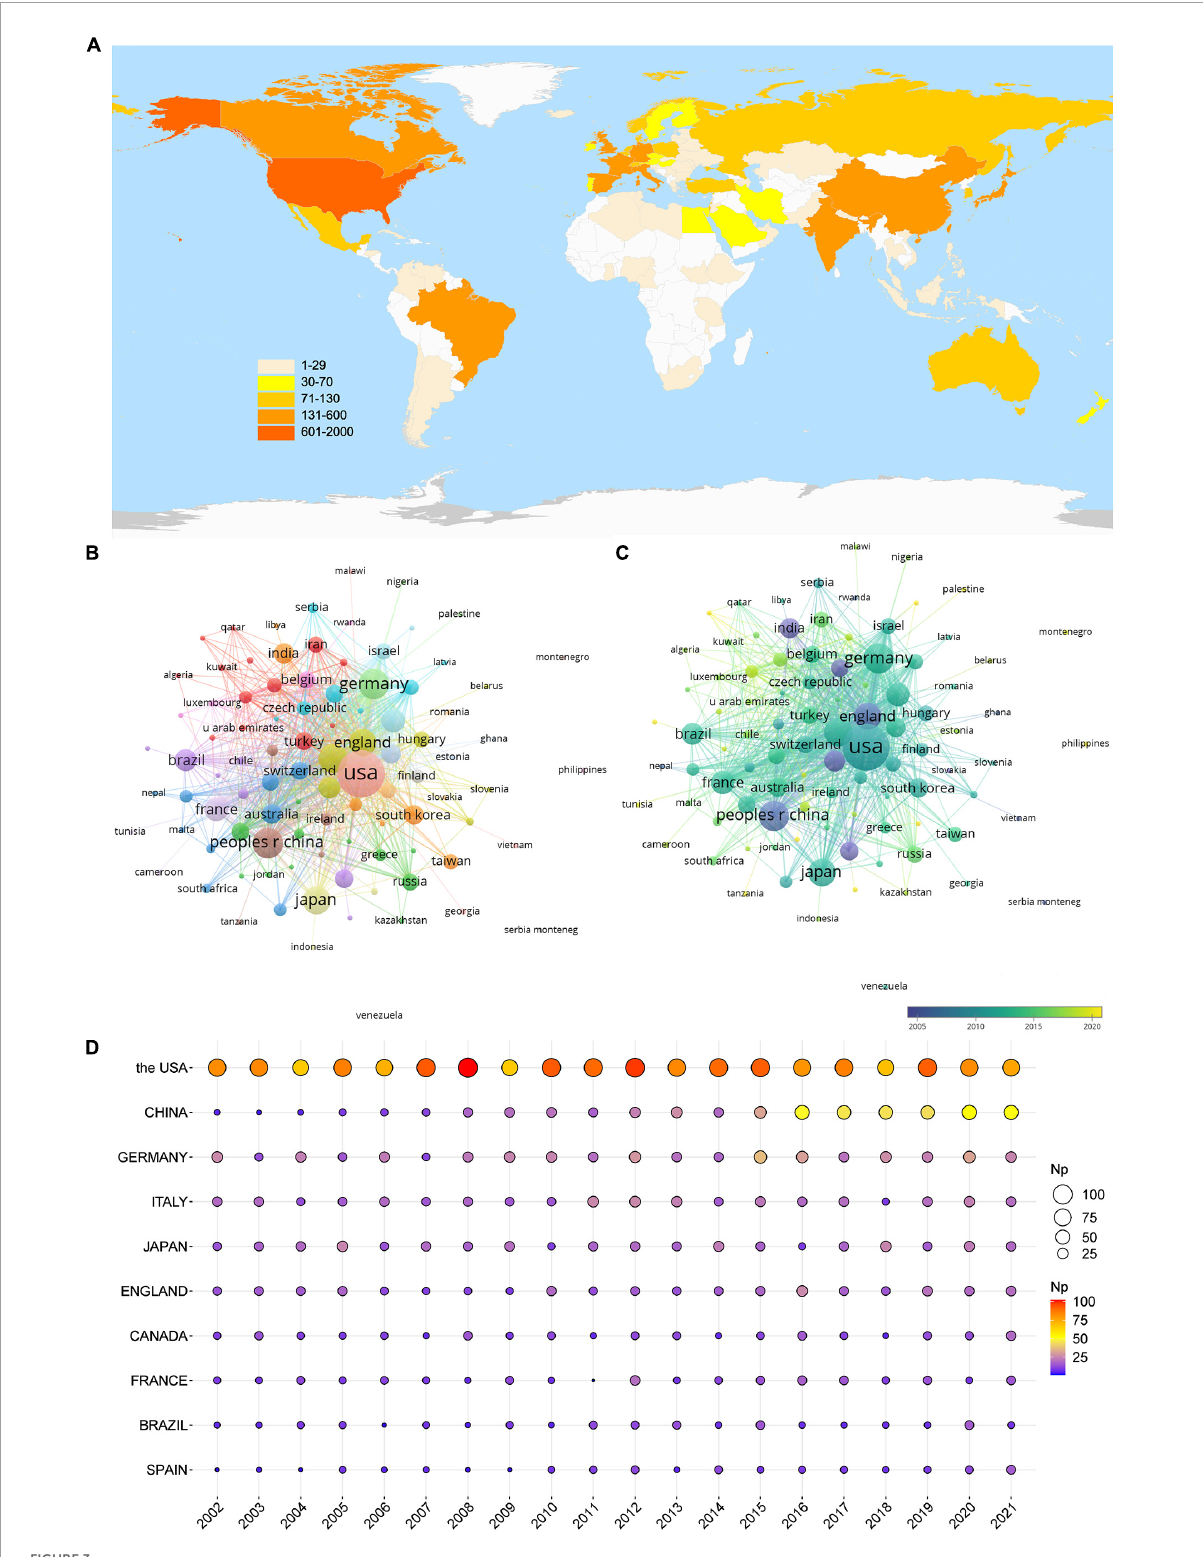
FIGURE3 Leading countries in glutamate in epilepsy. (A) Global geographical distribution of the publication. (B) Co-occurrence of countries. (C) Visualization of countries based on APY. (D) The annual publication of the top 10 countries.